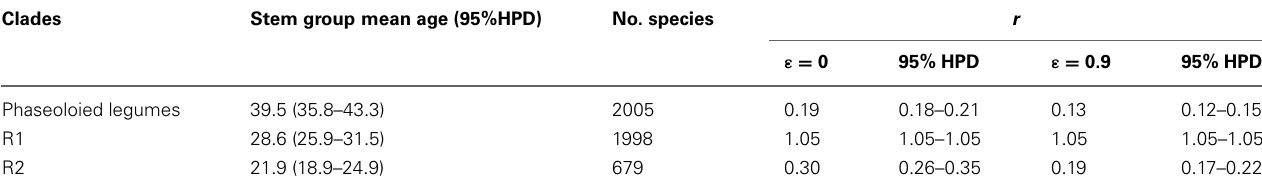
Table 2 | Net diversification rates ( r ) calculated for the phaseoloid legumes, nodes R1 and R2.